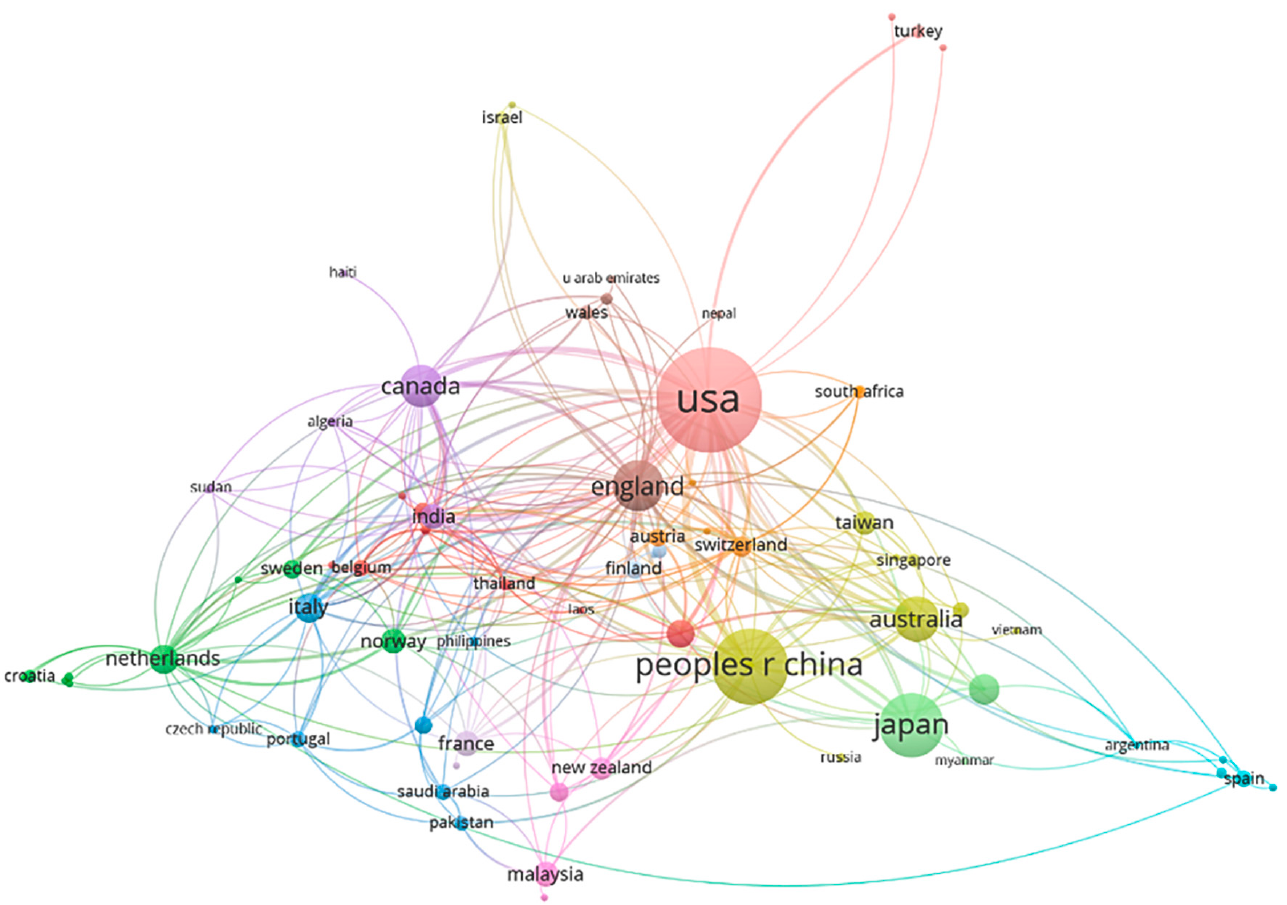
Figure A2. Collaboration network map of main institutions.